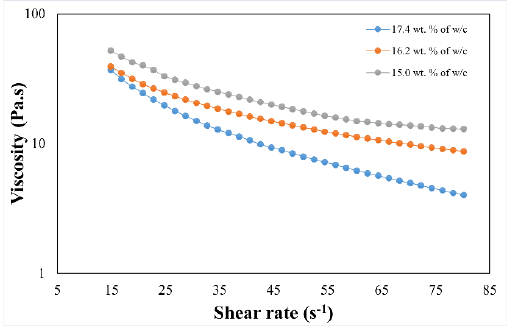
Figure 2. Data of viscosity as a function of shear rate for porcelain clay.